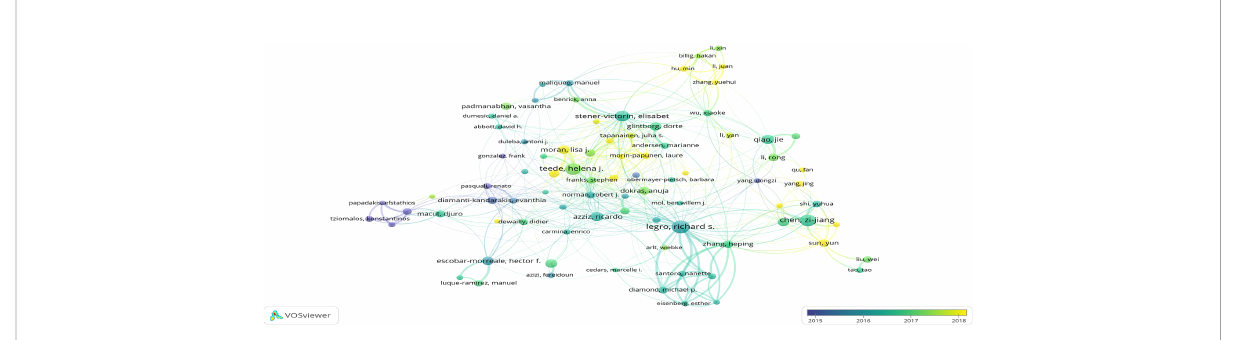
FIGURE 7 A co-authorship overlay visualization map of authors by VOSviewer.